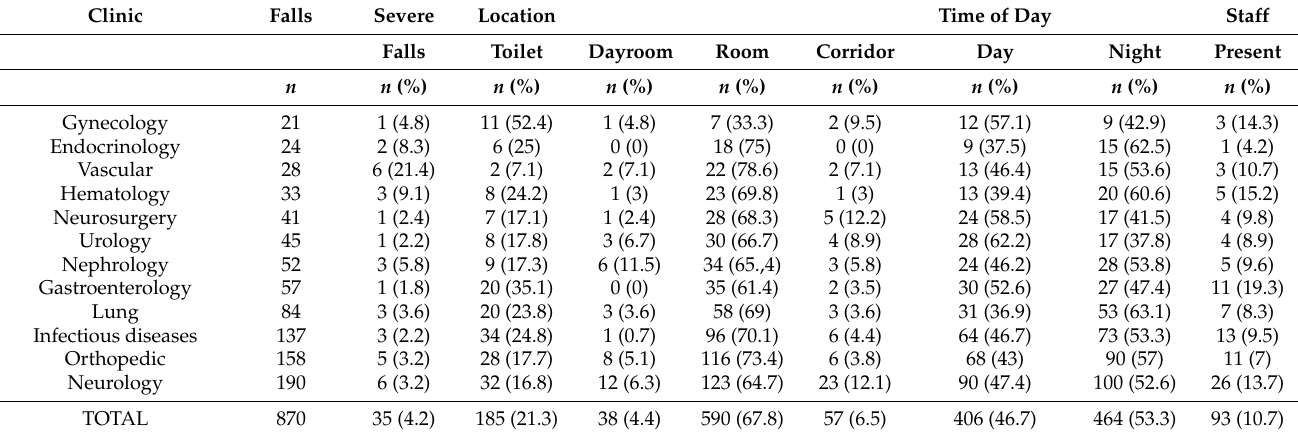
Table 1. Inpatient falls at the different clinics ( n = 12) and extrinsic characteristics of the inpatient falls. Clinic